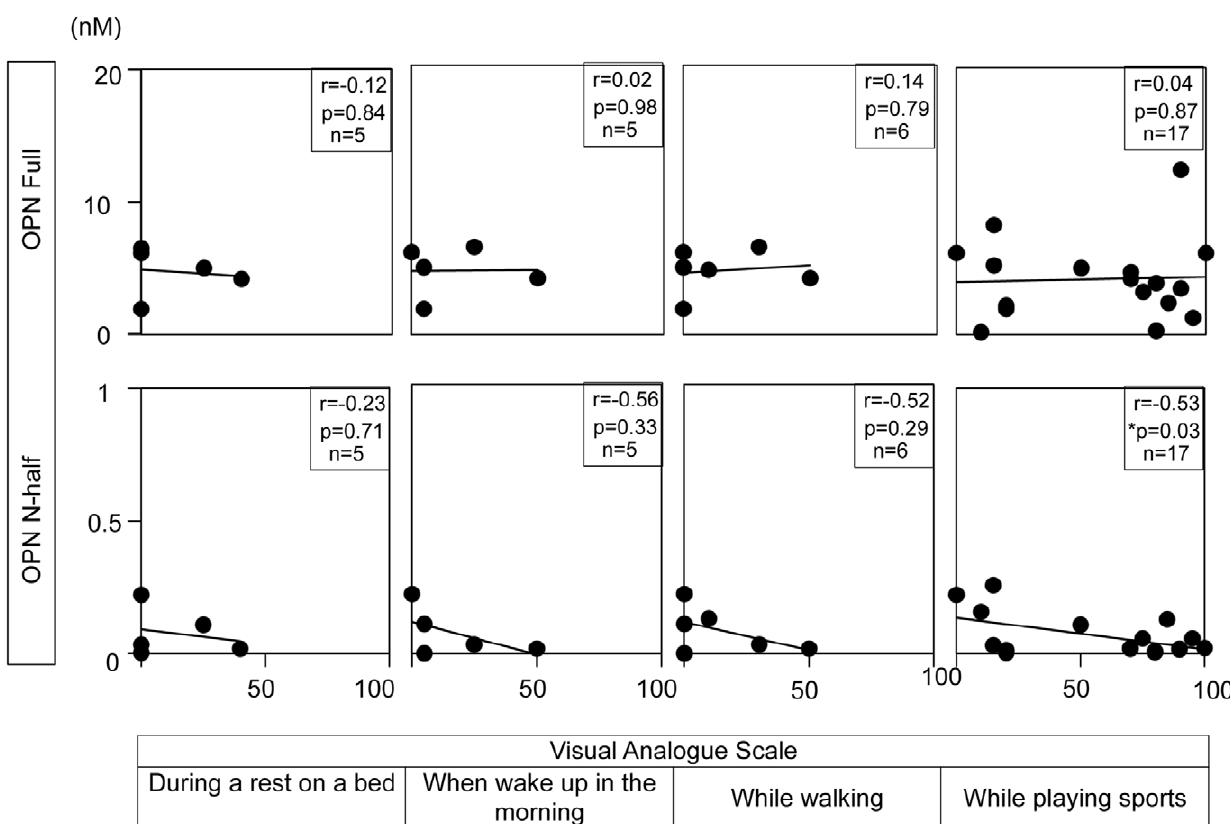
Figure 5. OPN N-half levels in synovial fluid are negatively correlated with the severity of joint pain in patients who ruptured ACL greater than 1 month ago. VAS was collected from patients who ruptured ACL more than 1 month ago using a questionnaire described in Table S2 in an examination room at our university hospital. Number of samples, correlation coefficient, and p value are indicated in each figure.